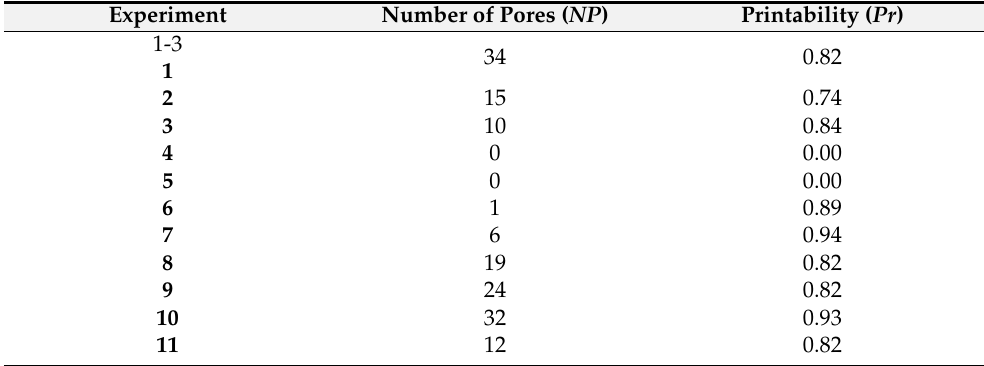
Table 1. Design of experiments: number of pores and printability obtained for each experiment